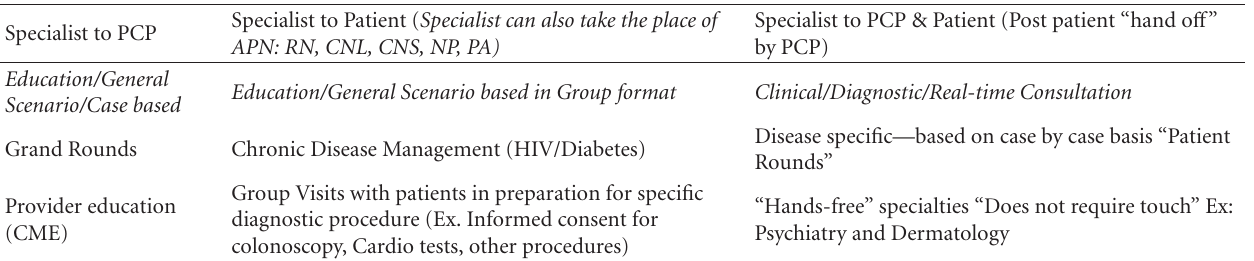
Table 2: Summary of the three types of telemedicine